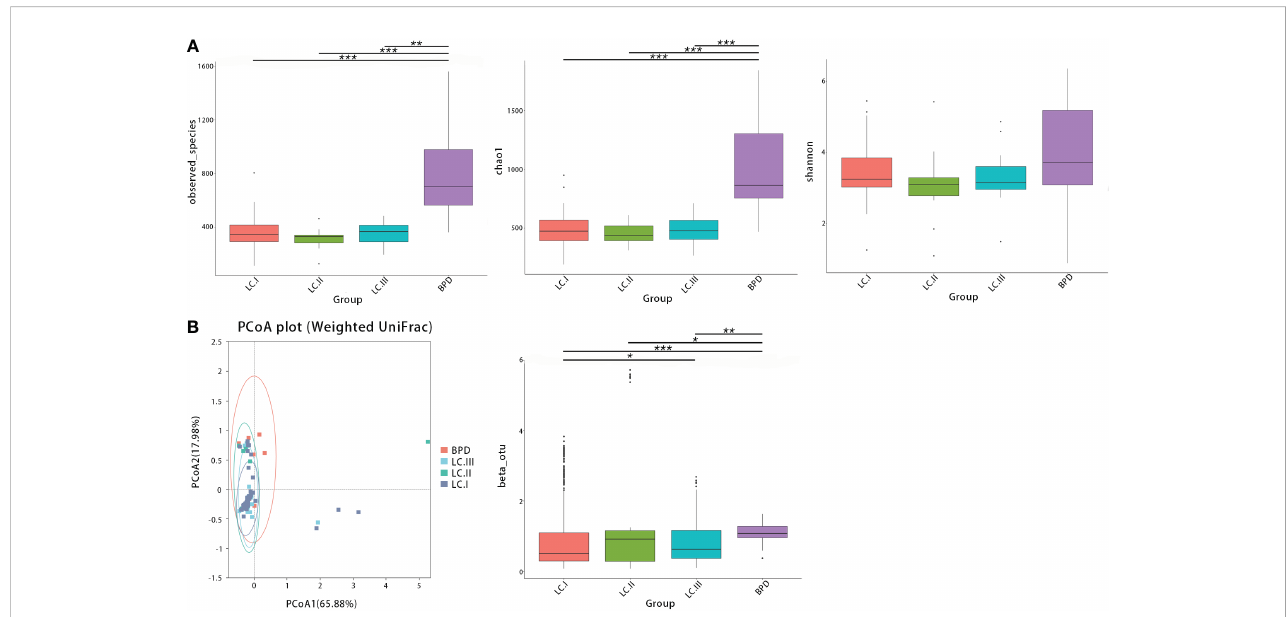
FIGURE 3 The alpha- and beta-diversity of respiratory microbiota in lung cancer patients by different TNM stages [stage I (LC.I) vs . stage II (LC.II) vs . stage III (LC.III)]. (A) No signi fi cant differences in observed OTUs, Shannon, and Chao1 were observed between different lung cancer TNM stages. Signi fi cant differences were observed between benign pulmonary diseases (BPD) and all stage I – III lung cancer cases regarding observed OTUs and Chao1 richness estimator. (B) Principal coordinate analysis (genus level) using the weighted UniFrac distance showed similar clusters of respiratory microbiota between lung cancer at different TNM staging and different clusters were found between benign pulmonary diseases and all lung cancer cases. * means 0.01 ≤ P < 0.05; ** means 0.001 ≤ P < 0.01; *** means P <